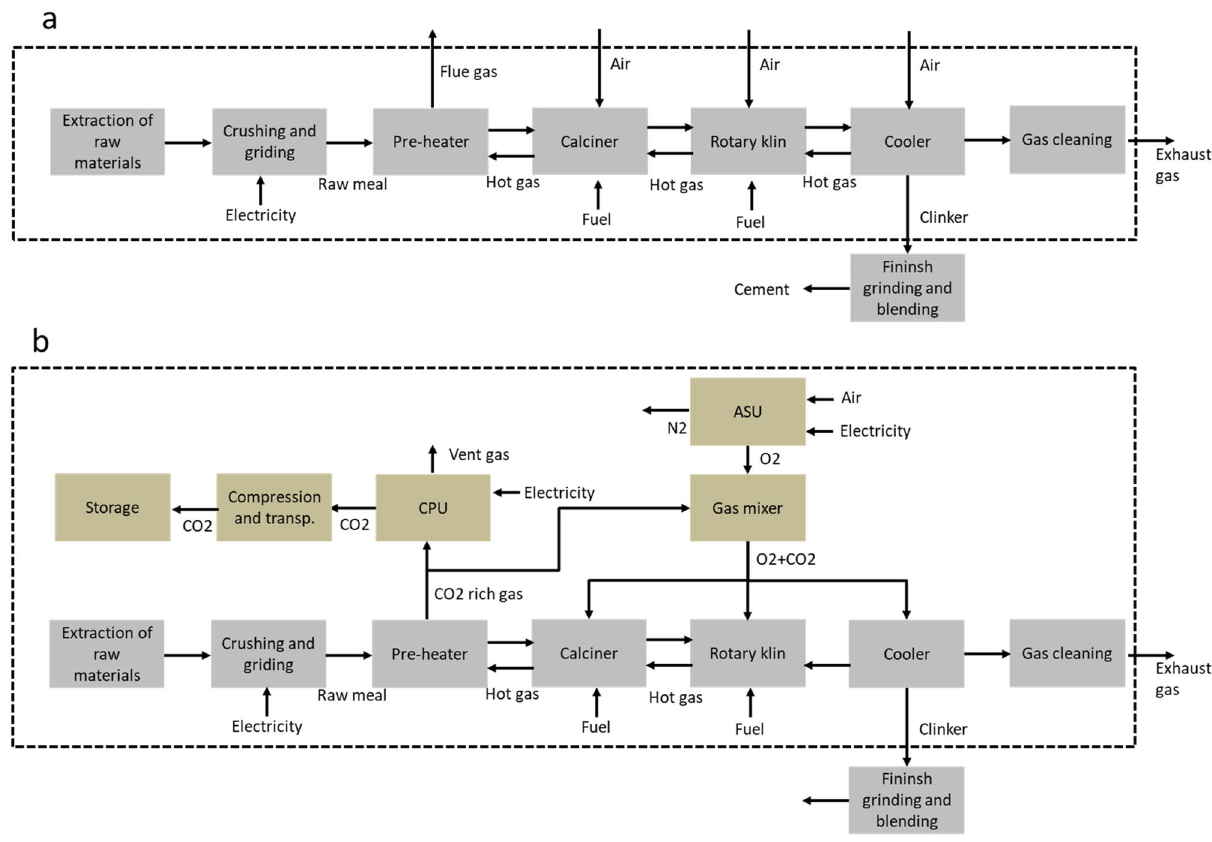
Figure 1. Main stages of the conventional cement production process ( a ) and retrofitted cement plants for oxyfuel combustion and CO 2 capture ( b ). Product systems are indicated inside the dashed boxes. ASU: air separation unit; CPU: CO 2 purification unit. Adapted from 4,19